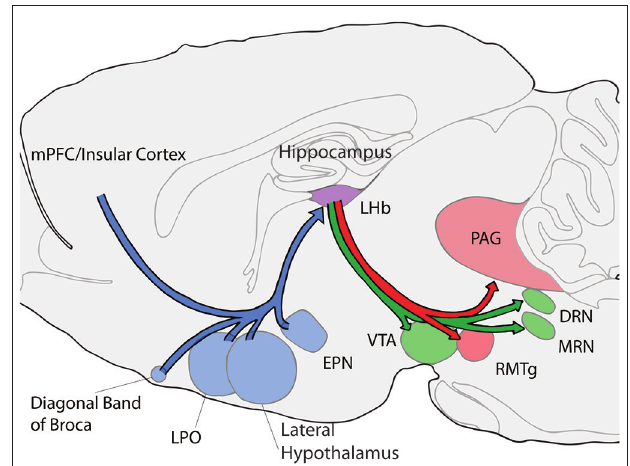
FIGURE 1 | Schematic of selected afferent and efferent connections of the lateral habenula (LHb; shown in purple). Afferent connections/ structures are shown in blue, efferent connections are shown in red, and bidirectional connections are in green. LHb, lateral habenula; PAG, periaqueductal gray; DRN, dorsal rahpe; MRN, median raphe; RMTg, rostromedial tegmental nucleus; VTA, ventral tegmental area; LPO, lateral preoptic area; EPN, entopeduncular nucleus; and mPFC, medial prefrontal